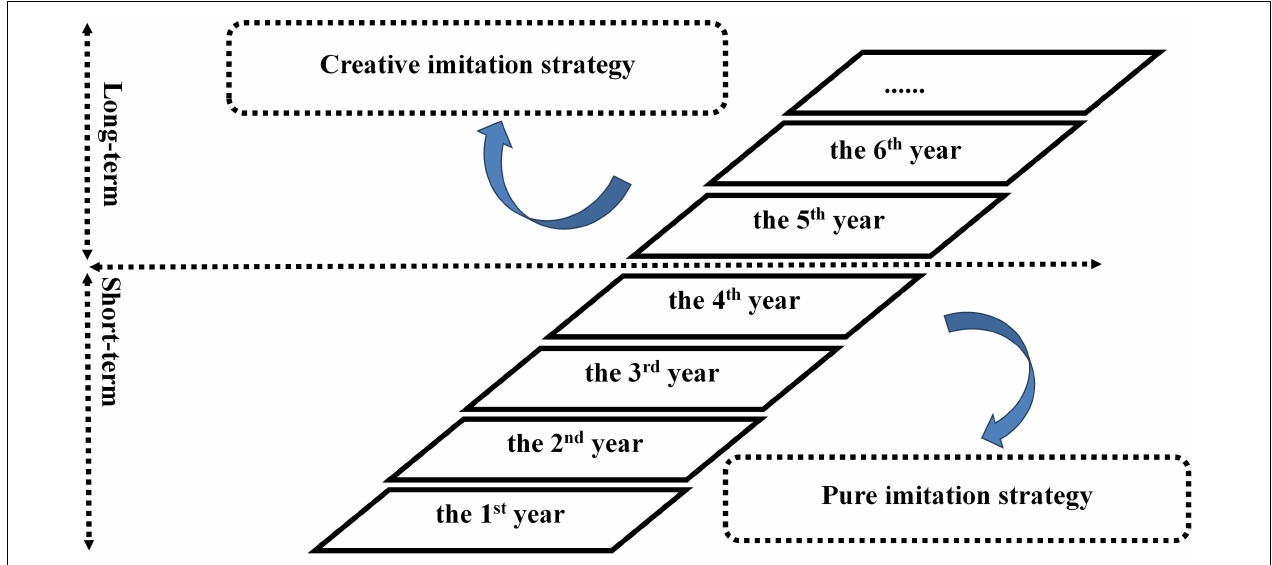
FIGURE 5 | Specific selection of imitation strategy for sustainable competitive